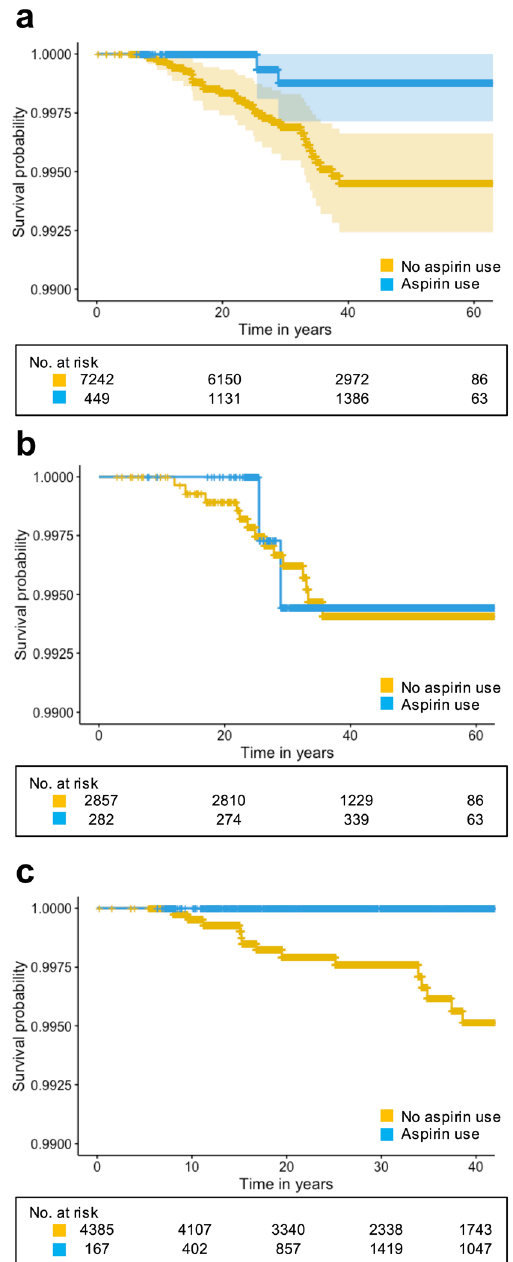
Figure 1. Kaplan–Meier plot comparing the rates of SAH in participants reporting regular aspirin use and those not. ( a ) All participants included in this study. ( b ) All participants included in the original cohort. ( c ) All participants included in the offspring